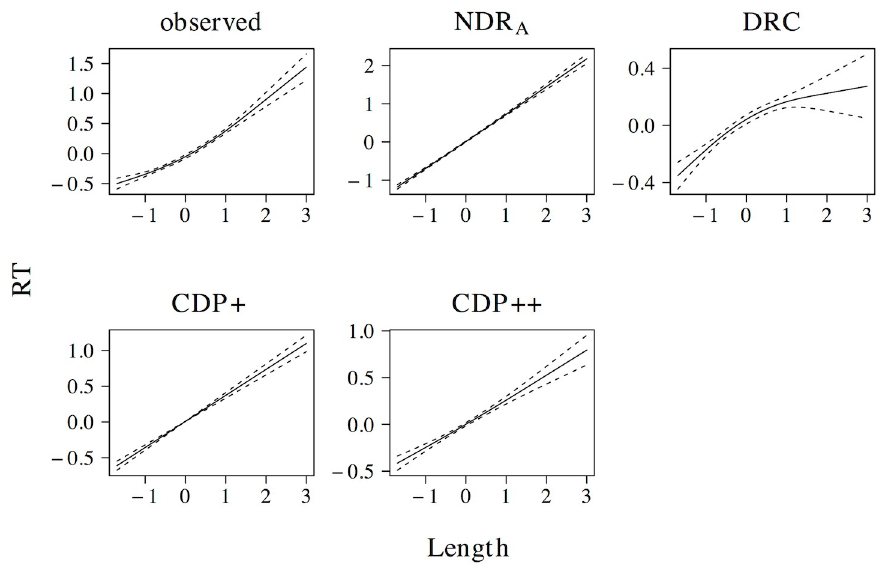
Fig 5. Length. The effect of length in word